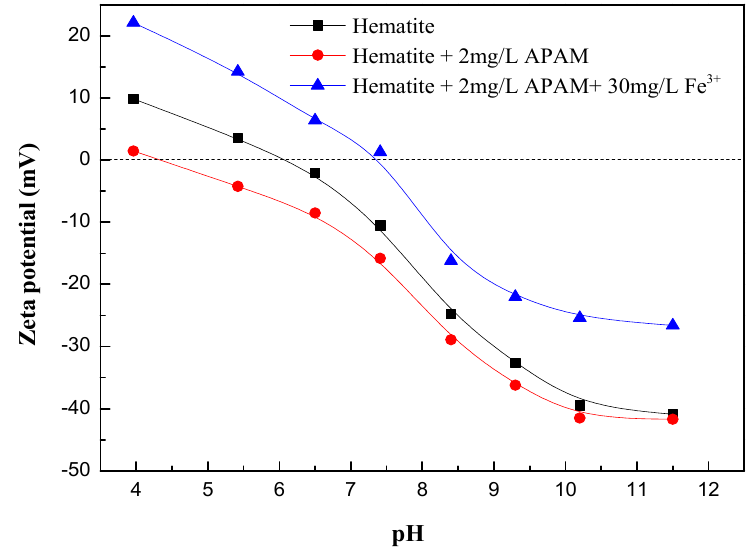
Figure 5. Effect of pH on the zeta potentials of hematite-APAM in the presence of Fe 3+ .